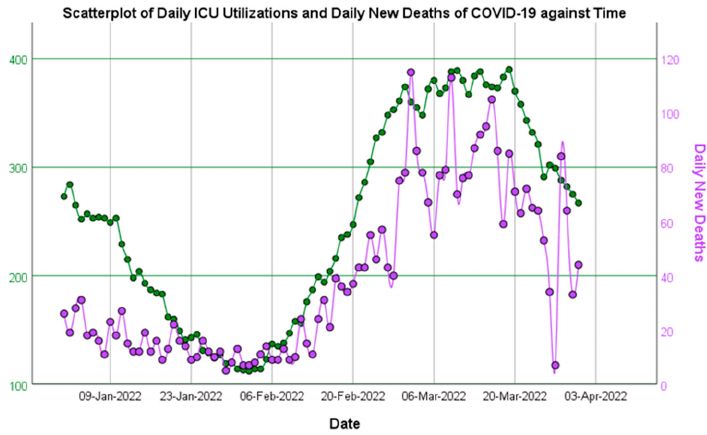
Figure 2. Scatter plot of daily ICU utilization (green line) and daily new deaths (purple line) of COVID-19 in Malaysia against time, from 1 January 2022 to 31 March 2022. Raw data were sourced from GitHub repository by Ministry of Health Malaysia [13].